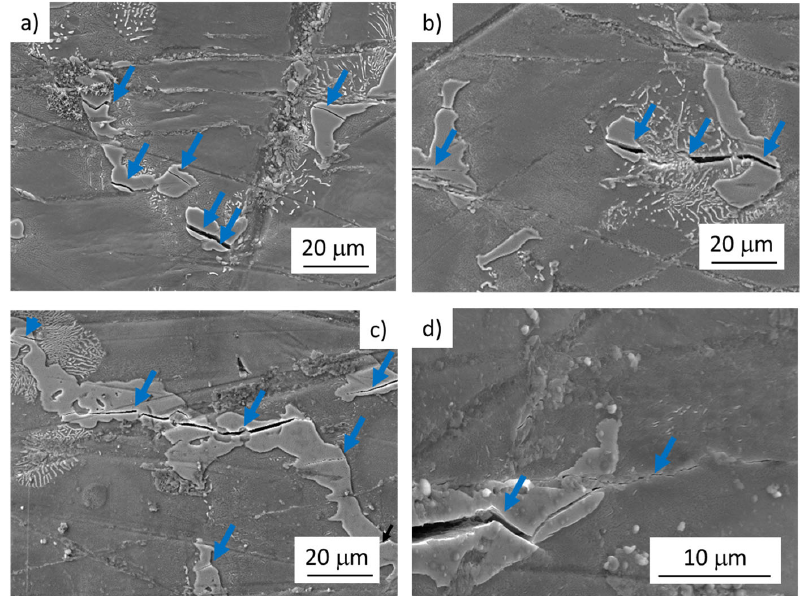
Figure 5. Fatigue crack initiation of AZ91 cast specimens tested at very high frequency. Blue arrows indicate the cracks in Mg 17 Al 12 particles; ( a ) broken intermetallic particles; σ a = 82 MPa, N f = 4,841,760 cycles, f = 20 kHz; ( b ) broken intermetallic particles with cracks growing to the material; σ a = 82 MPa, N f = 4,841,760 cycles, f = 20 kHz; ( c ) broken intermetallic particles; σ a = 65 MPa, N f = 141,804,000 cycles, f = 20 kHz; ( d ) broken intermetallic particle with crack growing to the material; σ a = 65 MPa, N f = 141,804,000 cycles, f = 20 kHz.